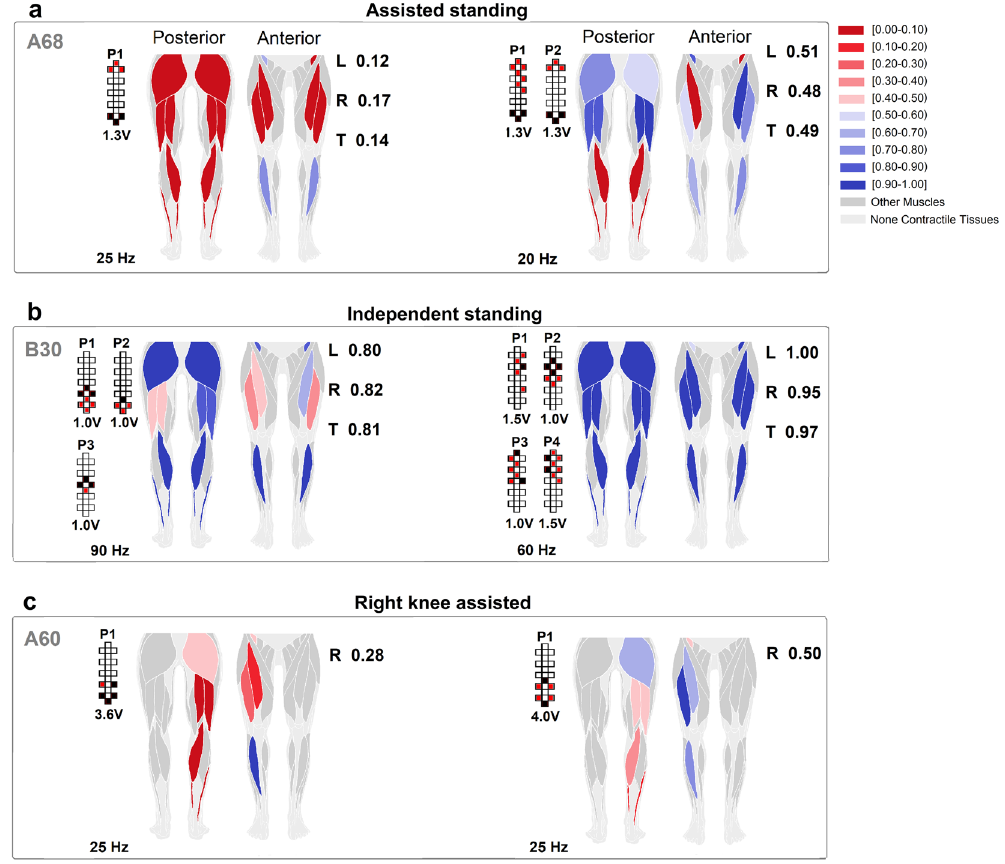
Figure 8. Colormap representing the effectiveness of standing muscle activation. The effectiveness of standing muscle activation is ranked by the prediction algorithm (see Methods). For each investigated muscle represented in the anatomical schematics, shades of red color rank activations labeled as assisted standing, while shades of blue color rank activations labeled as independent standing. Exemplary effects of different epidural stimulation parameters on muscle activation ranking during: ( a) standing with external assistance for hips and knees extension; ( b) standing with independent lower limbs extension; ( c ) standing with one lower limb assisted (right side) while the contralateral limb achieved independent extension. Average ranking score for the investigated muscles of the left (L) and right (R) lower limb, as well as for all muscles pooled together (total, T) are reported. Research participants’ identification, stimulation amplitude, frequency and electrode configurations (cathodes in black, anodes in red, and inactive in white) are also